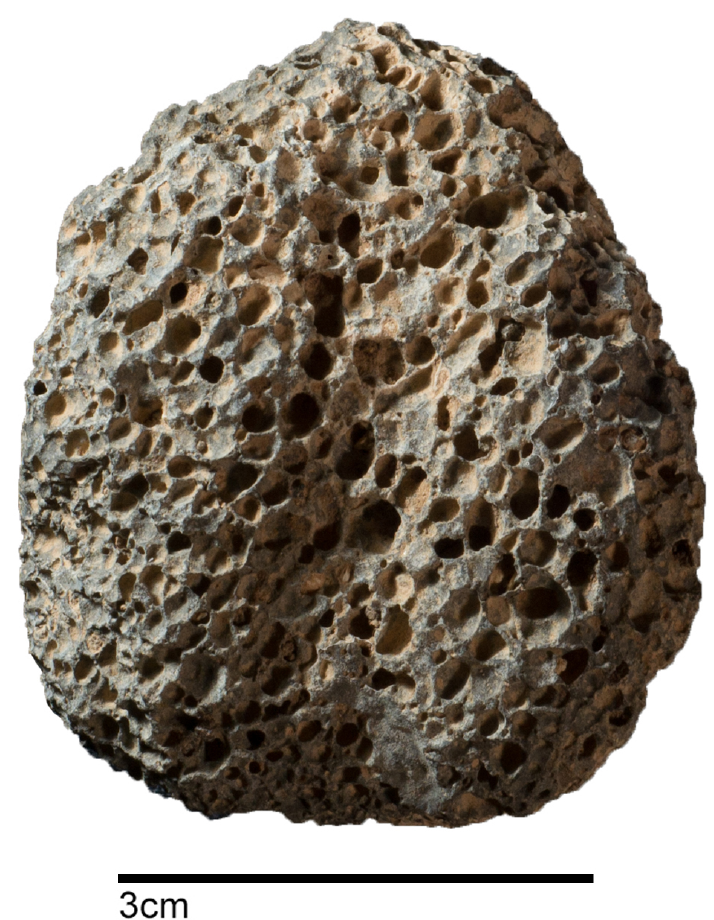
Figure 11: Grooved stone of scoria with a small bone fragment stuck in one of its